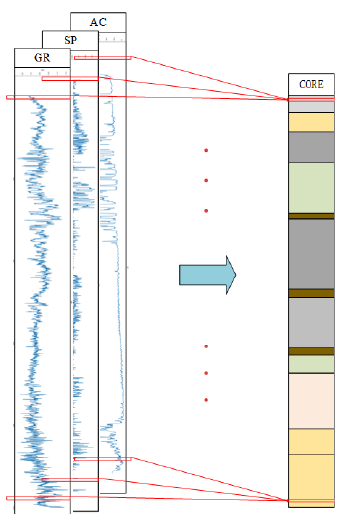
Figure 1. Intensive lithology prediction. Each logging curve in the semantic segmentation task is input as a channel to achieve intensive lithology prediction for each depth point. AC: acoustic log, SP: spontaneous potential log, GR: gamma ray